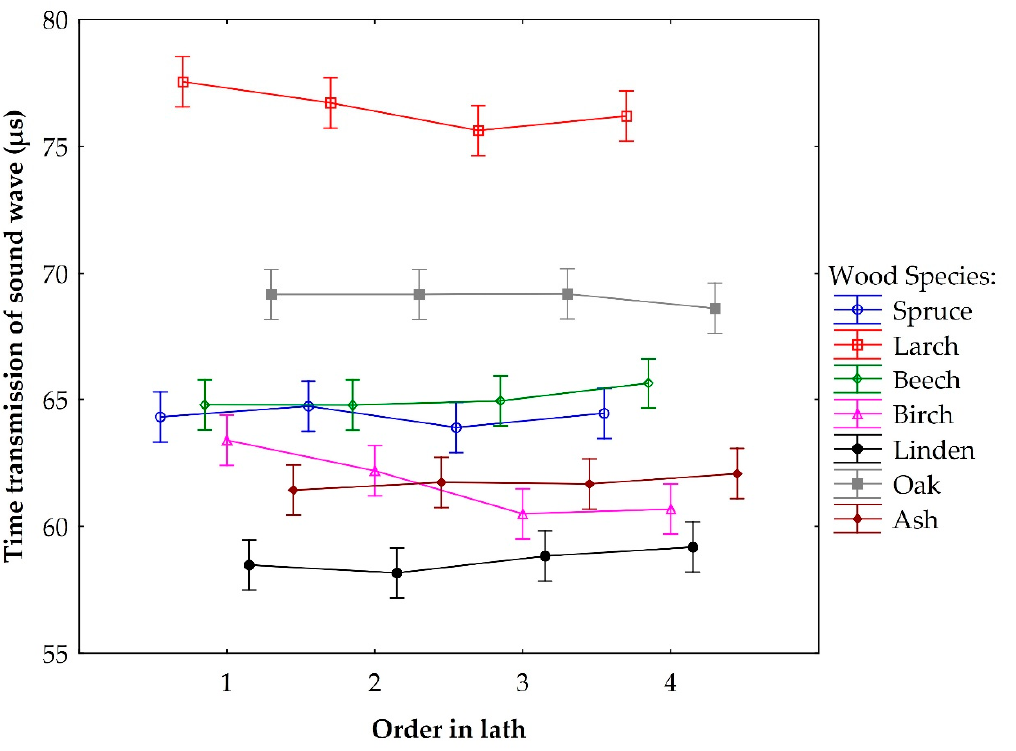
Figure 6. Graphical visualization of the transmission time of a sound wave of a specific wood species and samples in the parallel (longitudinal) direction in the lath.